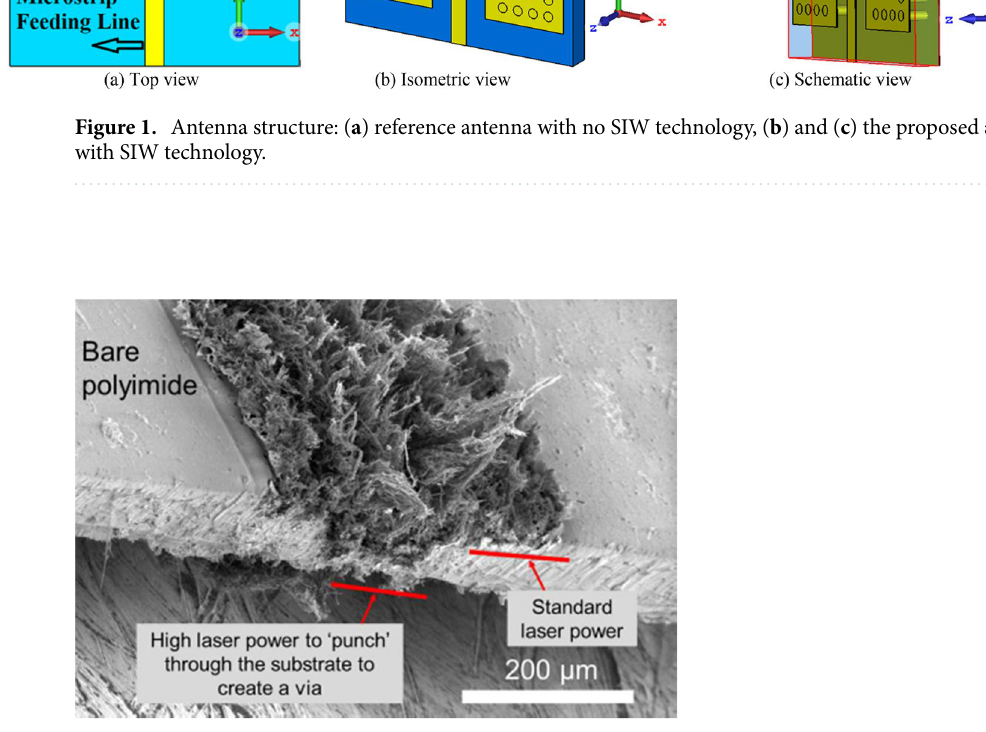
Figure 2. Scanning electron microscope (SEM) image of polyimide substrate (65º tilt angle) to highlight how the vias are fabricated by increasing the scribing laser power to ‘punch’ through the substrate and create an electrically conducting